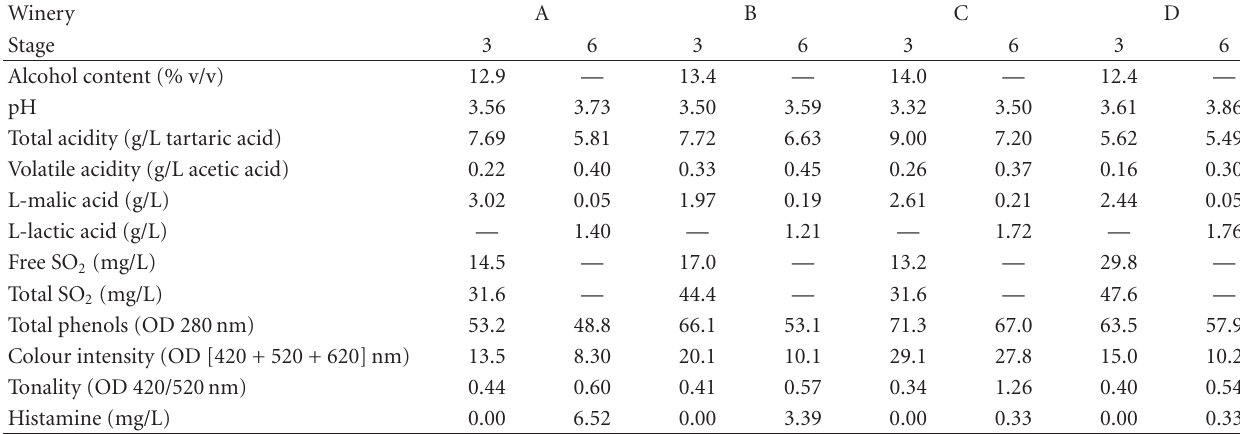
Lactobacillus sp. (—) not detected.